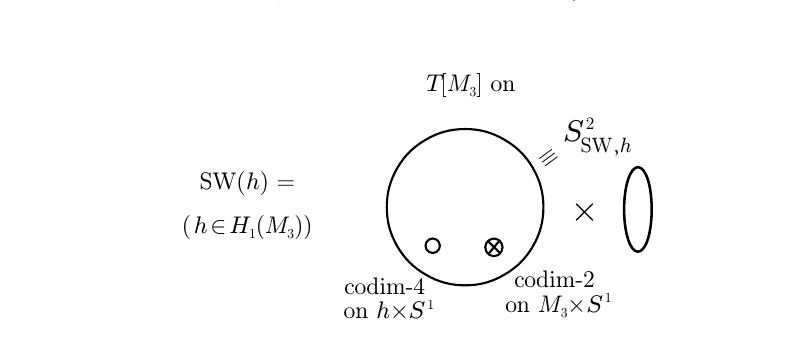
Figure 7 . SW invariants of M 3 as the index of T [ M 3 ] on S 2 (cid:2) S 1 with certain line operators inserted. In what follows we will use notation S 2